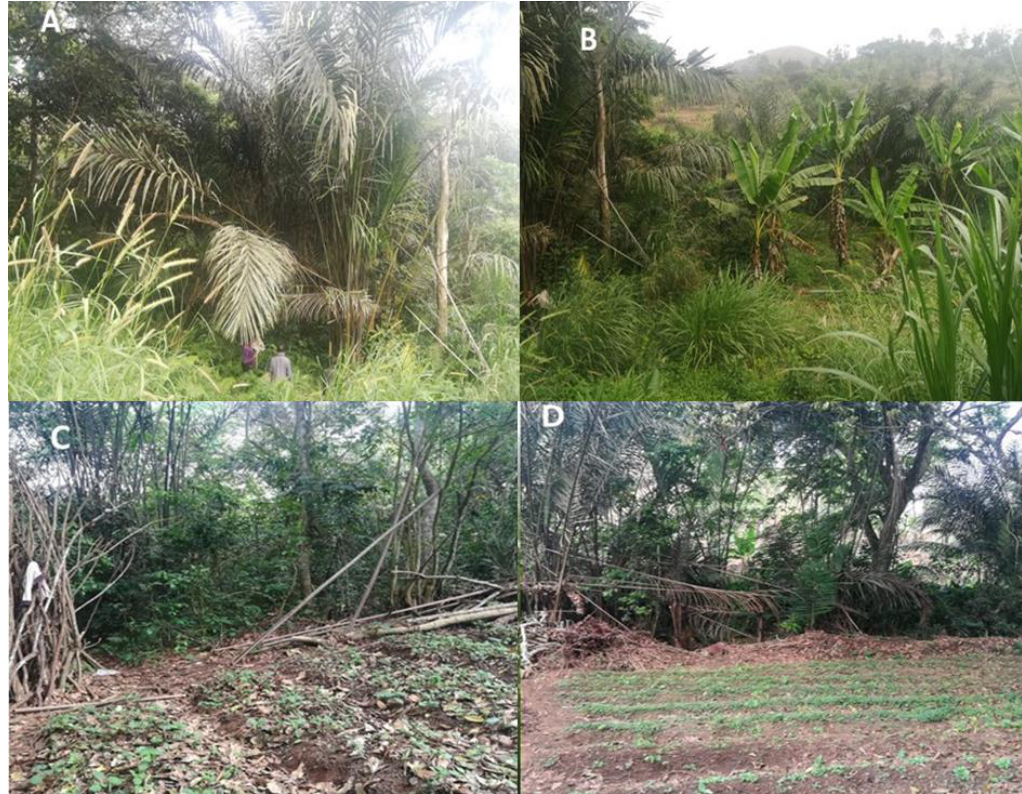
Figure 2. Rural (Fonakeukeu) and peri-urban (Toutsang) sites with raffia palm bushes ( A ), ‘Toutsang’ surrounded by a banana farm ( B ) and other cultivated areas in ‘Fonakeukeu’ ( C ) and ‘Toutsang’ ( D ).